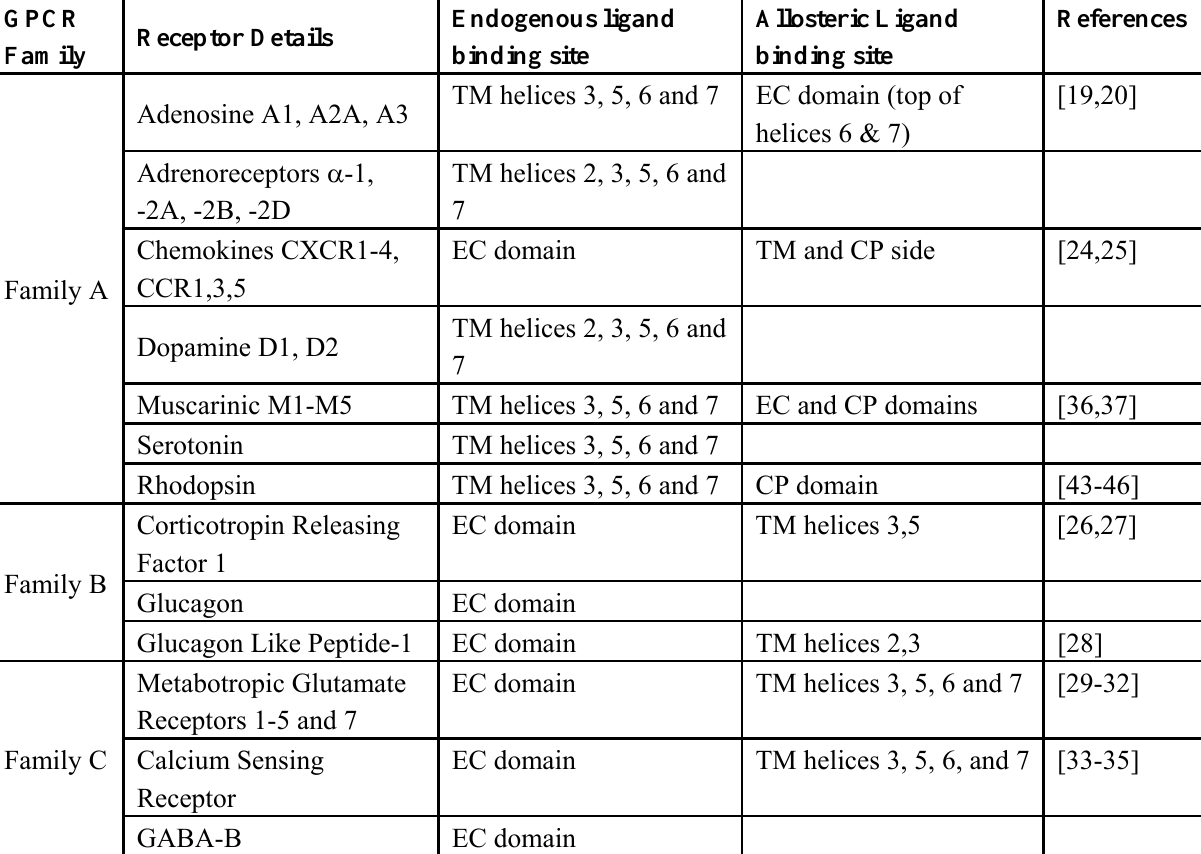
Table 1. Members of the major subfamilies of GPCRs exhibiting allosteric